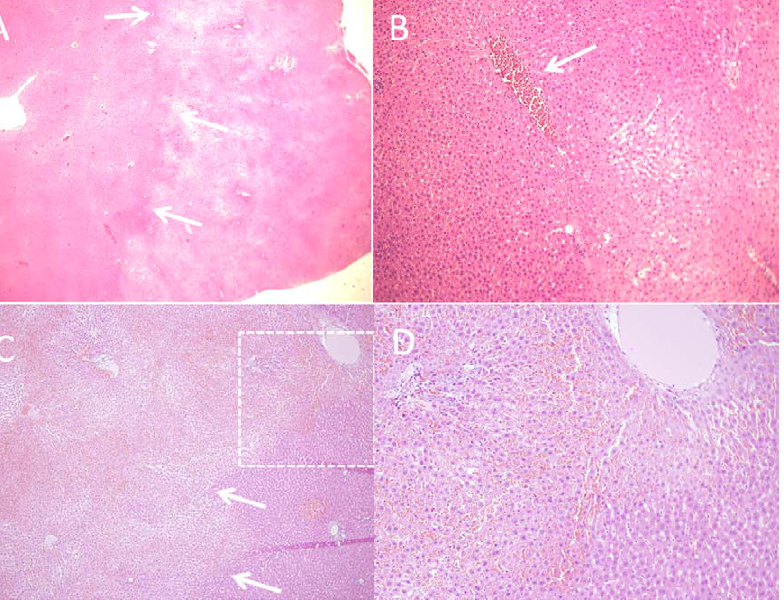
Figure 4. Simulation results of electric field around the liver cut (white line) following pulsing with 4 mm electrodes spaced apart by 7.2